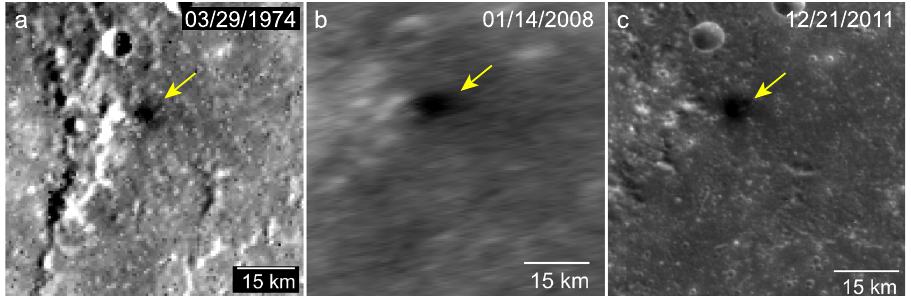
Fig. 5 Non-detectable re fl ectance changes of one dark spot (200 °E, 26 °N; yellow arrow) in more than 40 Earth years. a Mariner 10 image (mve_043_025; 664 m/pixel) acquired at 03/29/1974. b MDIS NAC Image (EN0108828493M; 547 m/pixel) acquired by MESSENGER during the Mercury fl yby at 01/14/2008. c MDIS WAC Image (EW0232711987G; 321 m/pixel) acquired by MESSENGER during the orbital operation at 12/21/2011. The images were taken with similar pixel scales and incidence angles. The images are provided by